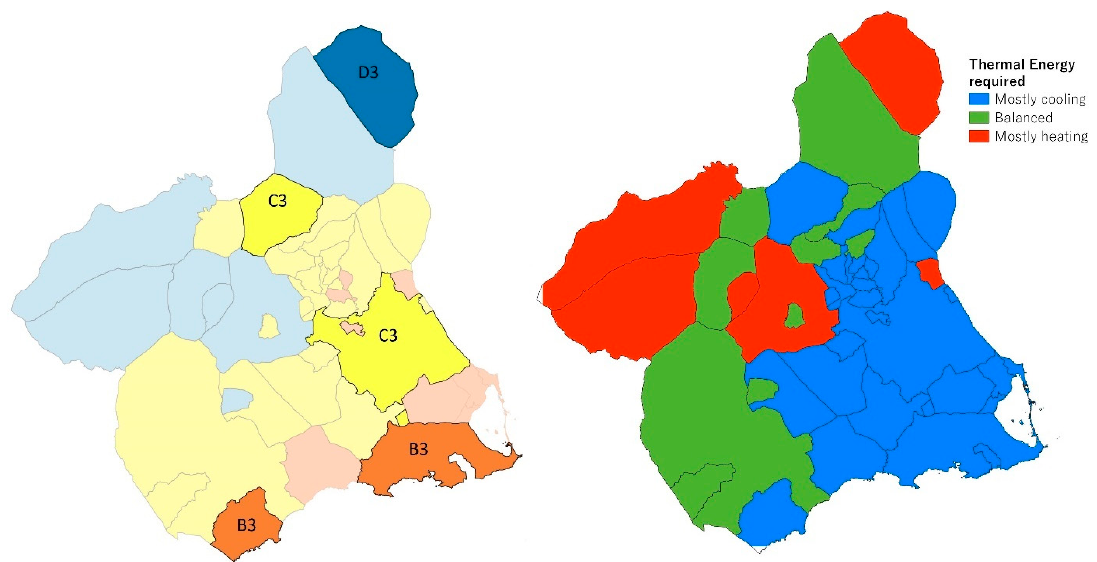
Figure 7. Climatic needs characterization. On the left, municipalities in the darker color with meteorological stations where HDD and CDD data are measured and, in lighter color, municipalities where HDD and CDD were estimated from those with real values. (Left) Climatic characterization based on the energy mode prevailing by municipality. In blue, municipalities where up to 75% are cooling needs; in green, municipalities where approximately half are for cooling and half for heating; and in red, municipalities where at least 75% of demand is for heating. Own elaboration.